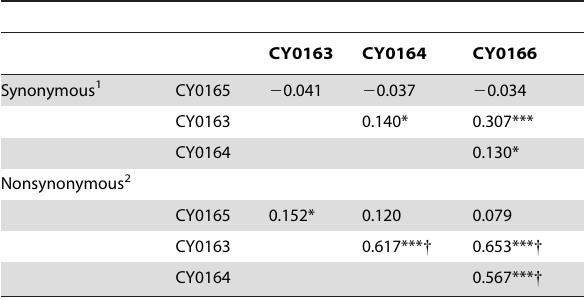
Table 4. Correlation coefficients between proportion variant at SNP sites in SIV from different